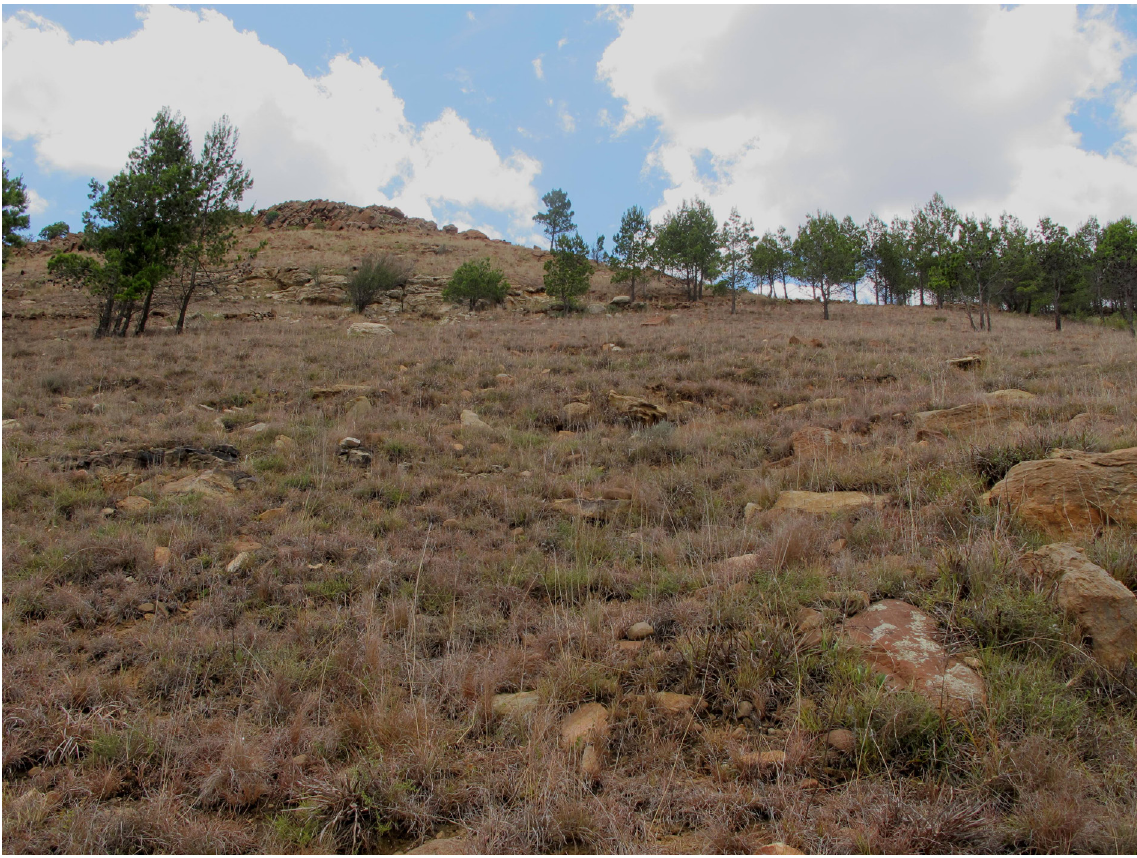
Fig. 7. Dordrecht Mountain, where a second population of Neoclita pringlei gen. et sp. nov. was first recorded in Dec. 2013 (photo: Lynette Clennell, Dordrecht, 31